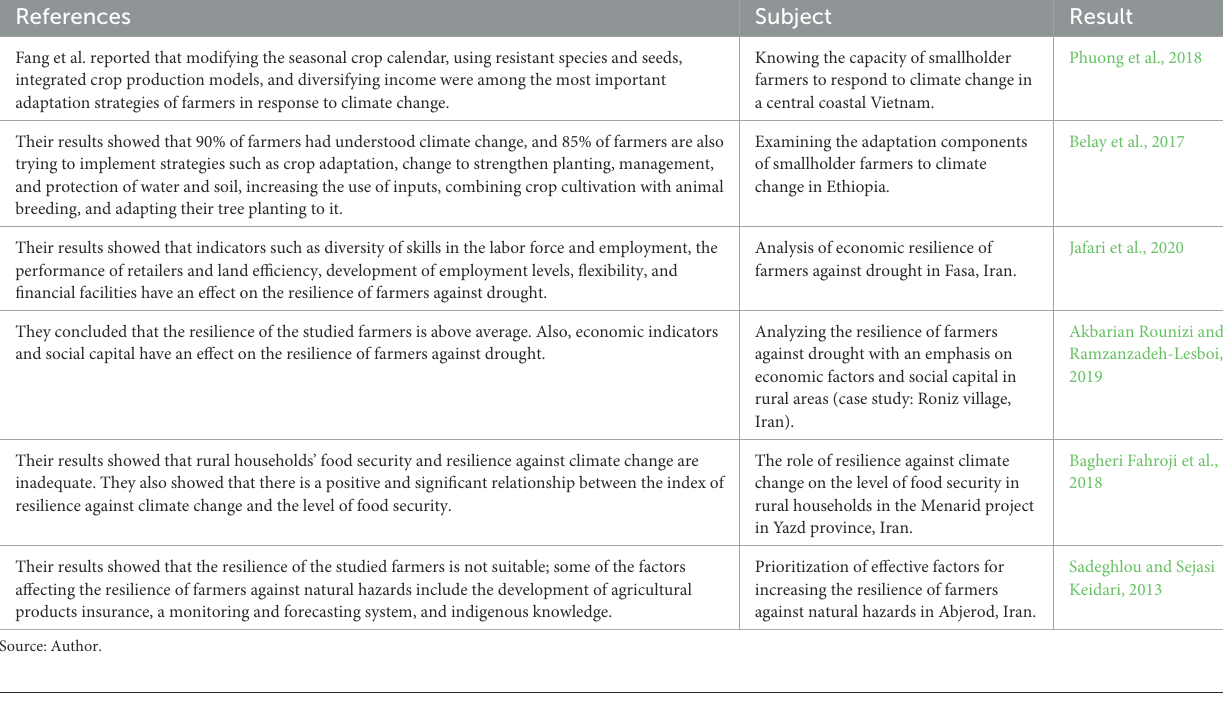
TABLE 2 Domestic and foreign studies in the field of resilience against climate change.